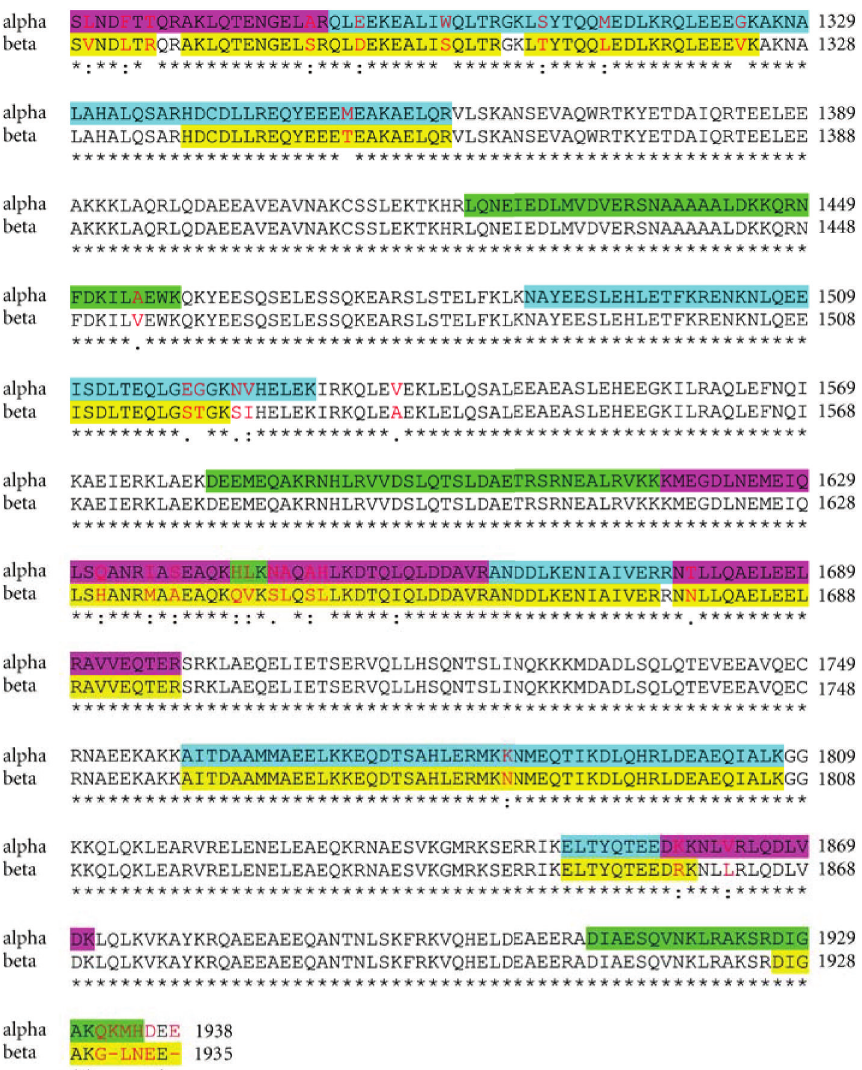
Figure 3: Specific peptides obtained by MALDI TOF/TOF (trypsin, Asp-N, and Lys-C proteases) and highlighted in multiple sequence align- ment (ClustalW 1.83) of MyHC α and MyHC β : yellow: HY MyHC β , blue: EU MyHC α , green: TH MyHC α , pink: overlap of EU MyHC α and TH MyHC α . Red letters: specific amino acids for each MyHC